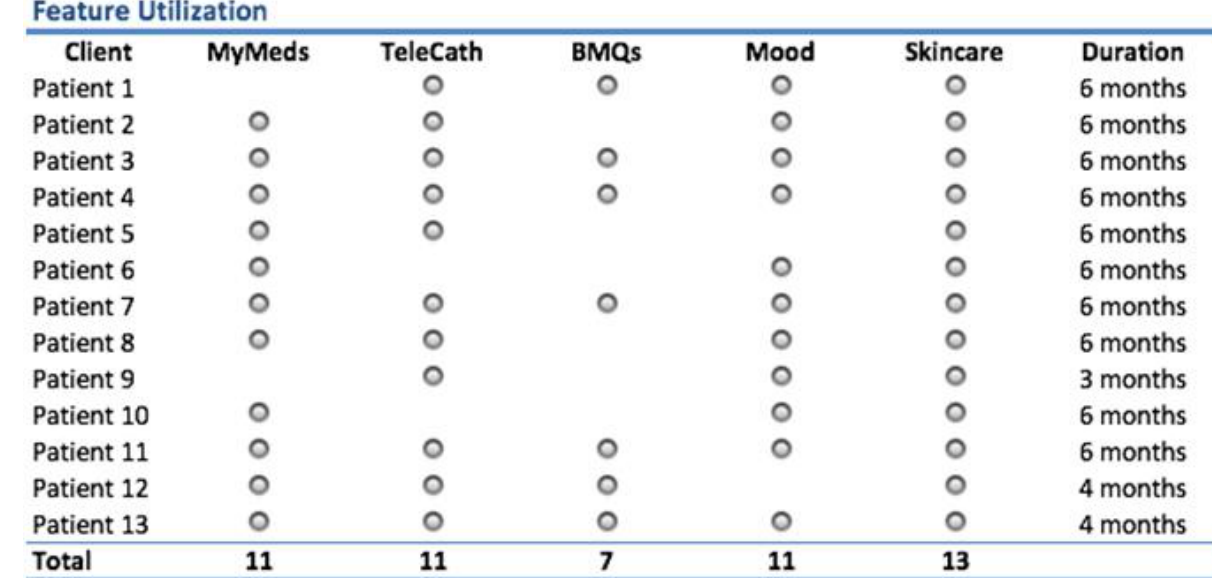
Figure 8. Apps features used by